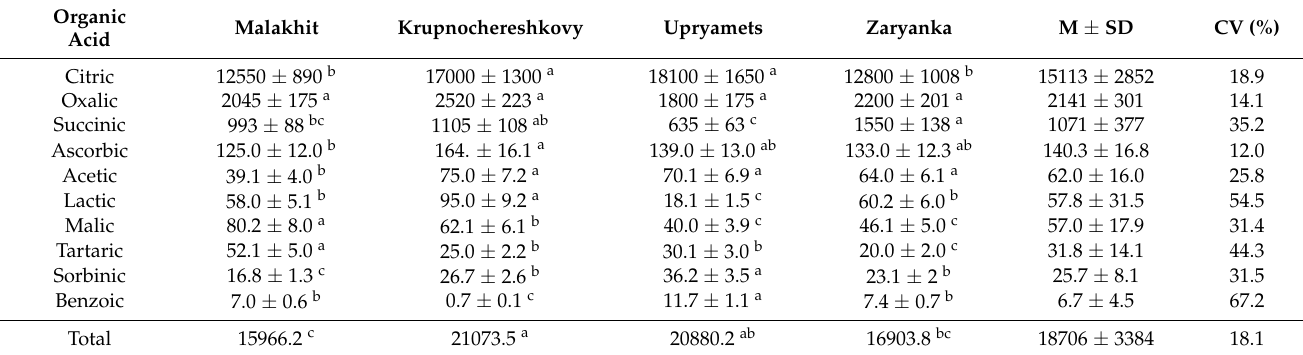
Table 3. Varietal differences in organic acid content in rhubarb juice (mg L − 1 ).